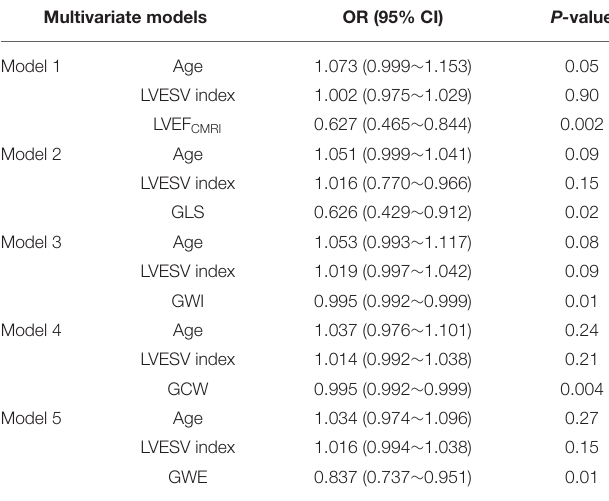
TABLE 5 | Multivariate logistic regression models to predict LV myocardial fibrosis.